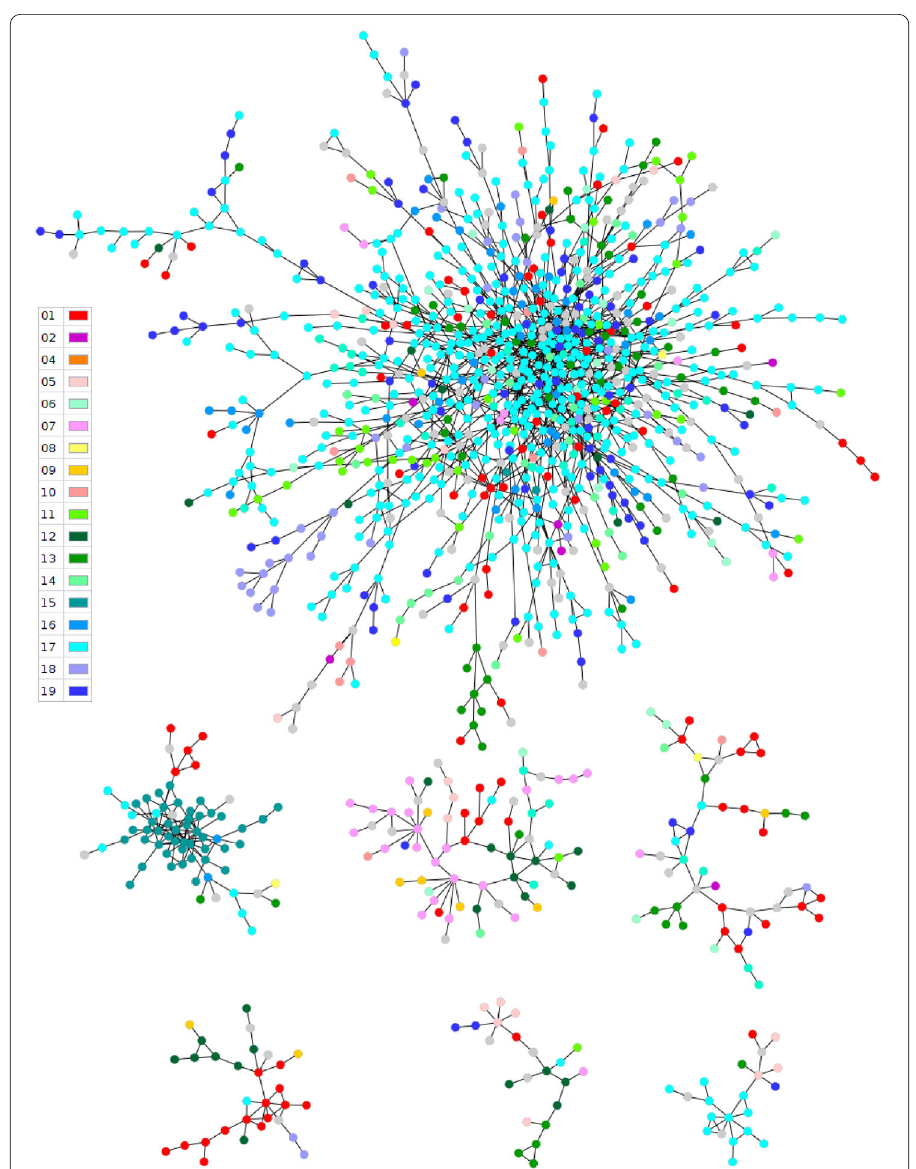
Figure 4 The network of Finnish families. Nodes represent families, links between two nodes are associations with offspring common to both families. The first seven connected components of the network are shown in descending order of sizes. The largest connected component (LCC) has 957 nodes and 1211 links. The next in the series have 68, 68, 49, 30, 22 and 21 nodes, respectively. The different colours represent different regions of origin for the families and are indicated in the legend. The families that could not be associated with a particular region are denoted in grey